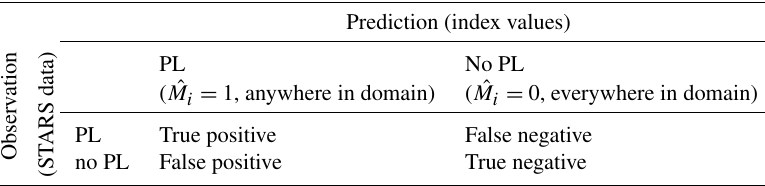
Table E1. Confusion matrix summarizing the classification scheme for task 1. In task 1 we test the performance of indices in distinguishing the time of PL occurrence.